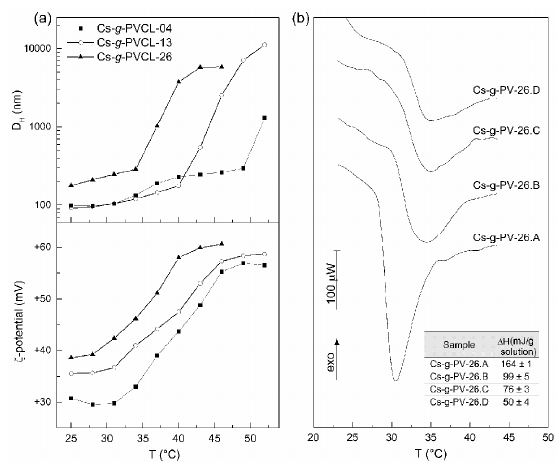
Figure 12. ( a ) Dependence of the hydrodynamic diameter, D H , on temperature of chitosan- g -PVCL aqueous solutions (pH 6) for different number-average molecular weights of PVCL-grafted chains (4, 13, and 26 kDa). Reprinted by permission from Springer Nature: [154], Copyright 2015. ( b ) Micro-DSC curve of 10 wt % aqueous solutions (pH 6) of chitosan- g -PVCL, varying the spacing between grafted side chains. Reprinted from [151], Copyright 2015, with permission from Elsevier.